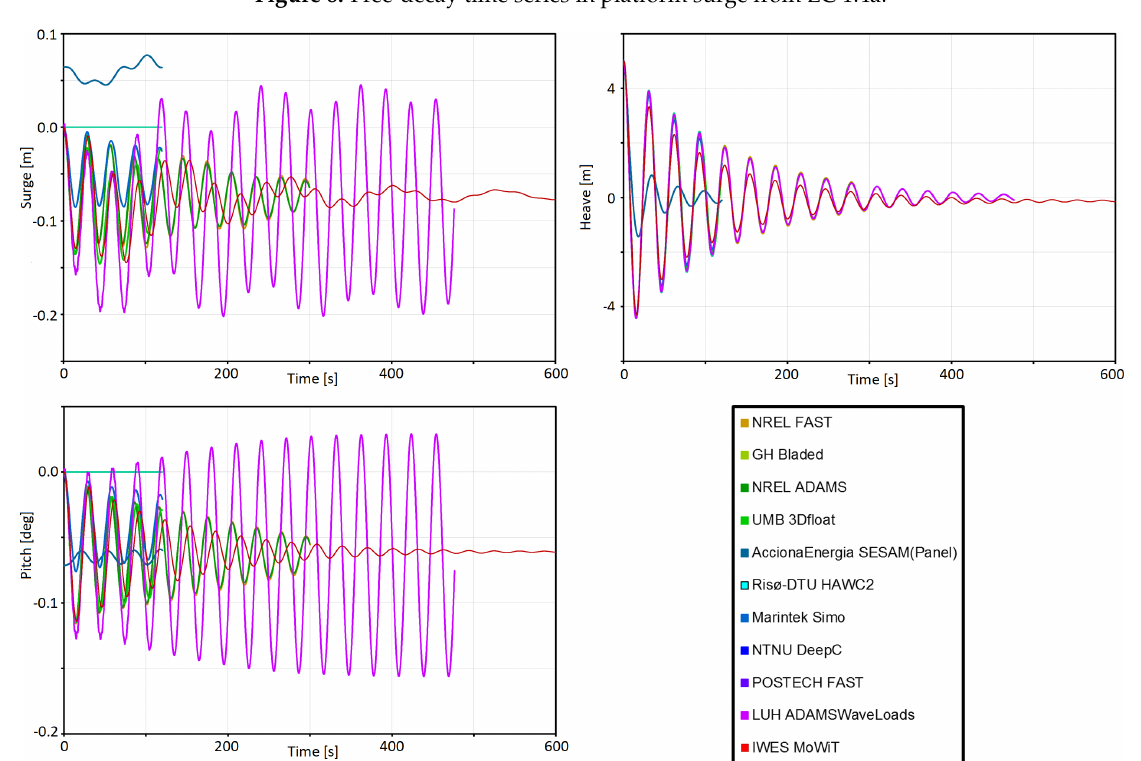
Figure 9. Free-decay time series in platform heave from LC